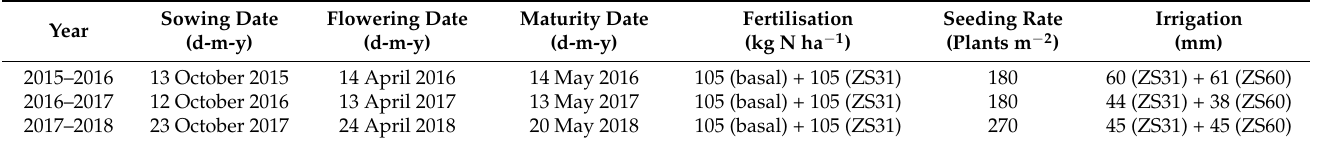
Table 1. Detailed information for field experiments conducted at Yanzhou in Shandong